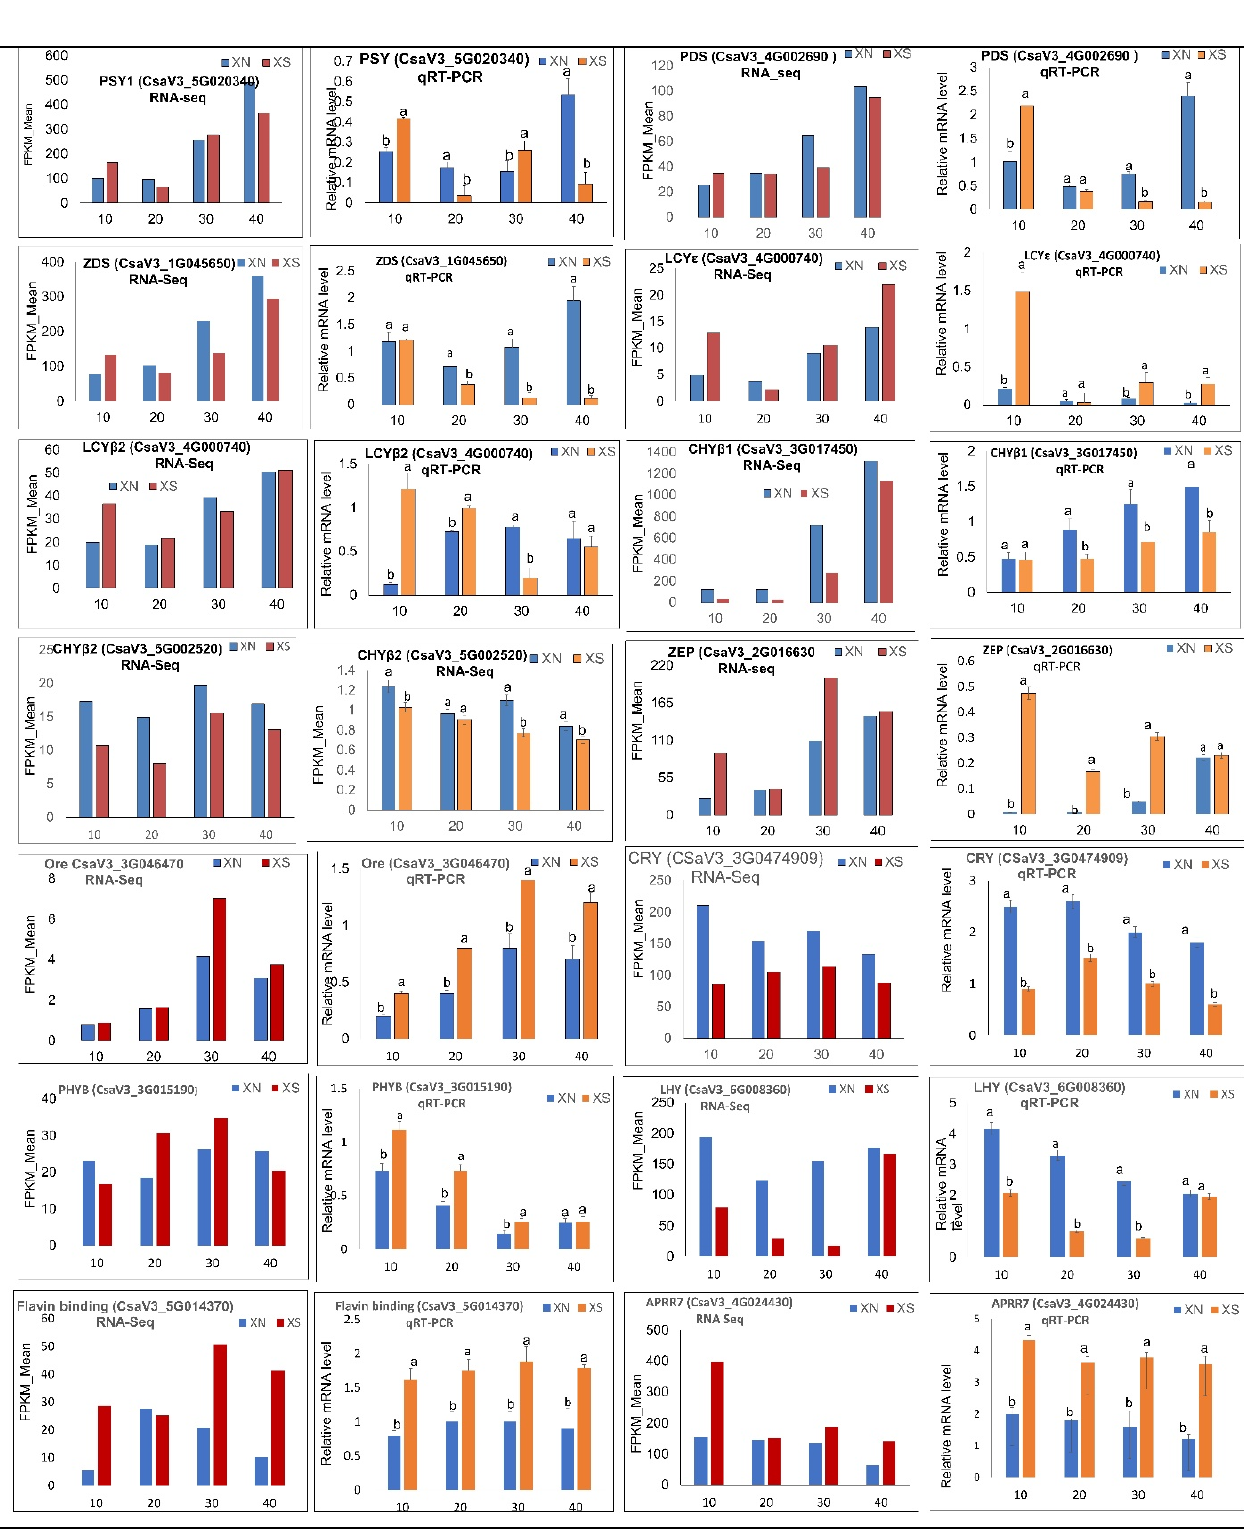
Figure 9. Validation of the expression of RNA-seq data by qRT-PCR using XIS (SWCC8) Cucumber cultivar. FPKM values were obtained via RNA-Seq and relative mRNA levels were obtained via qRT-PCR for putative carotenoid-related DEGs. Three technical replicates were performed for each biological replicate of each sample at 10, 20, 30, and 40 days after pollination. Error bars represent standard deviation. Different letters on bars at each sampling point indicate significant differences at p < 0.05). Phytoene synthase ( PSY ); Phytoene desaturase ( PDS ); Zeta-carotene desaturase ( ZDS ); lycopene- β - cyclase 2 ( LYB2 ); lycopene- Ɛ - cyclase ( LYE ); carotenoid β -hydroxylase ( CHYB1 and 2 ); Zeaxanthin epoxidase ( ZEP ); orange gene (Ore ); Cryptochrome ( Cry ); Phytochrome B ( PHY B ); late